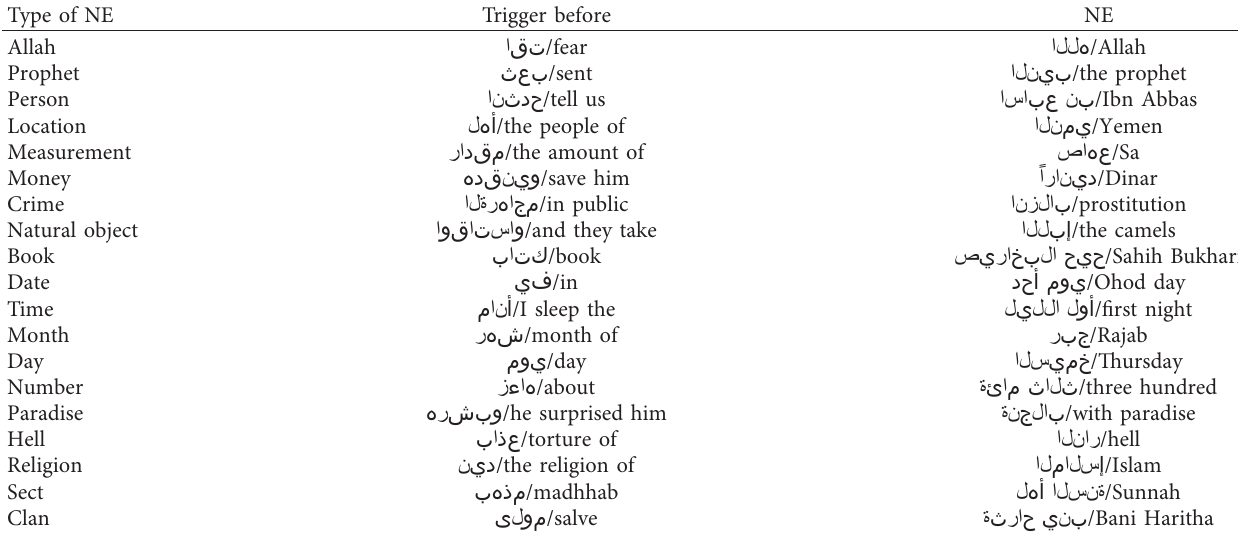
Table 4: Examples of TWB.